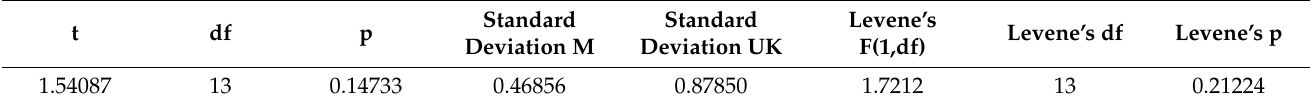
Figure 5. Modulus of elasticity of manufactured beams. Table 3. Student’s t -test for the modulus of elasticity, Levene’s analysis of variance.